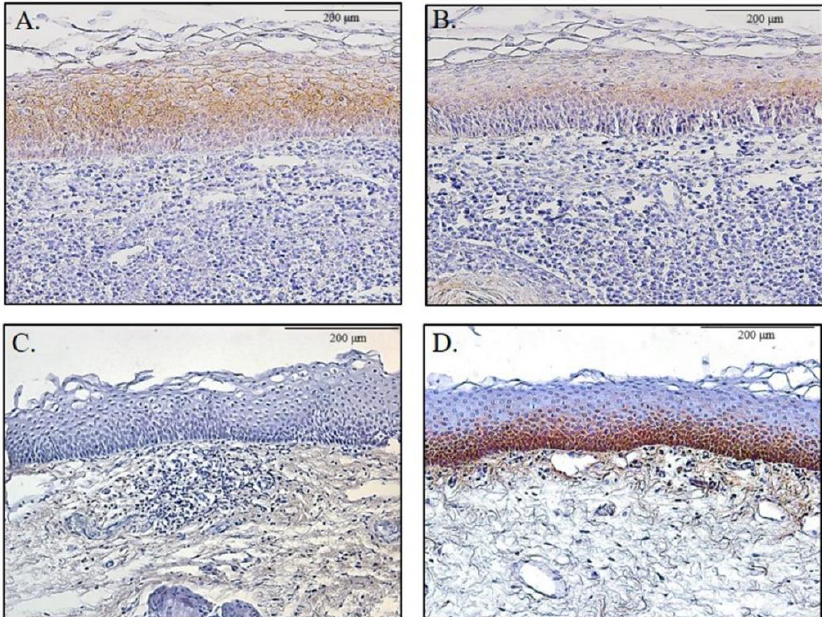
Figure 3. E-cadherin and MMP-7 expression in human pharyngeal mucosa. E-cadherin expression was significantly higher in those with reflux symptom index score of less than or equal to 13 ( A ) compared to those with a reflux symptom index score greater than 13 ( B ). The expression of MMP-7 was significantly higher in those with a reflux symptom index score greater than 13 ( D ) compared to those with a reflux symptom index score of less than or equal to 13 ( C ).